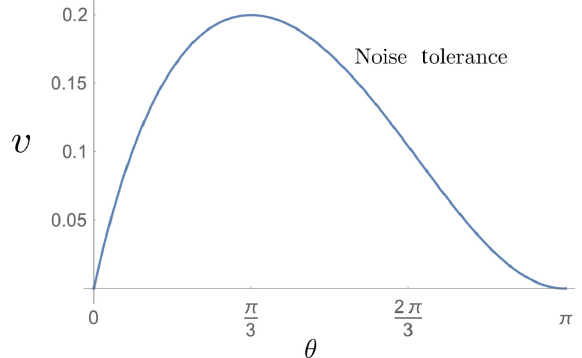
FIG. 6. The images of the ideal quantum states and effects under a depolarization map for some fixed value of v . FIG. 7. The maximum value of the parameter v for the depolarizing noise model that allows a violation of our non- contextuality inequality, as a function of the Bloch sphere angle θ between the two